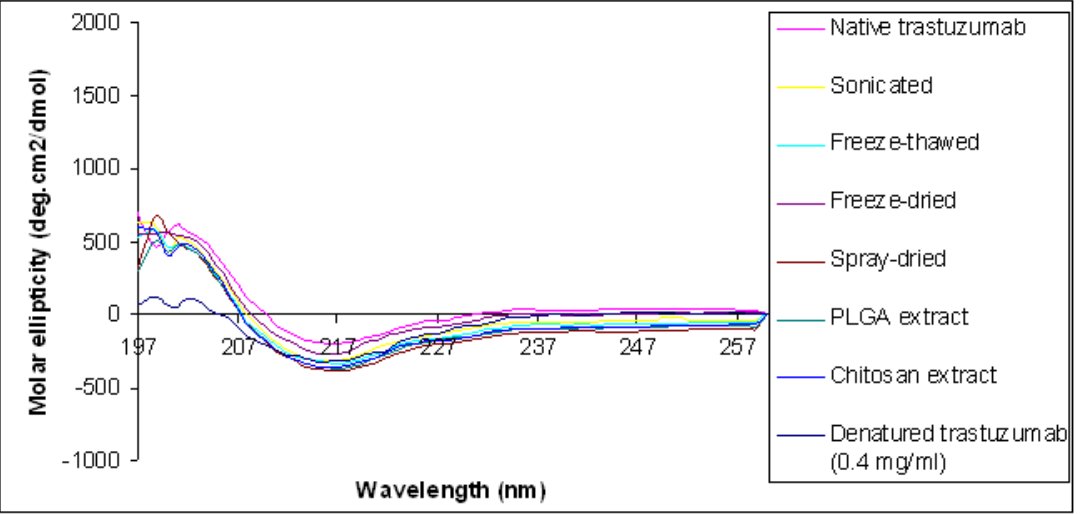
Figure 3. Circular dichroism (CD) spectra analysis of trastuzumab subjected to various mechanical